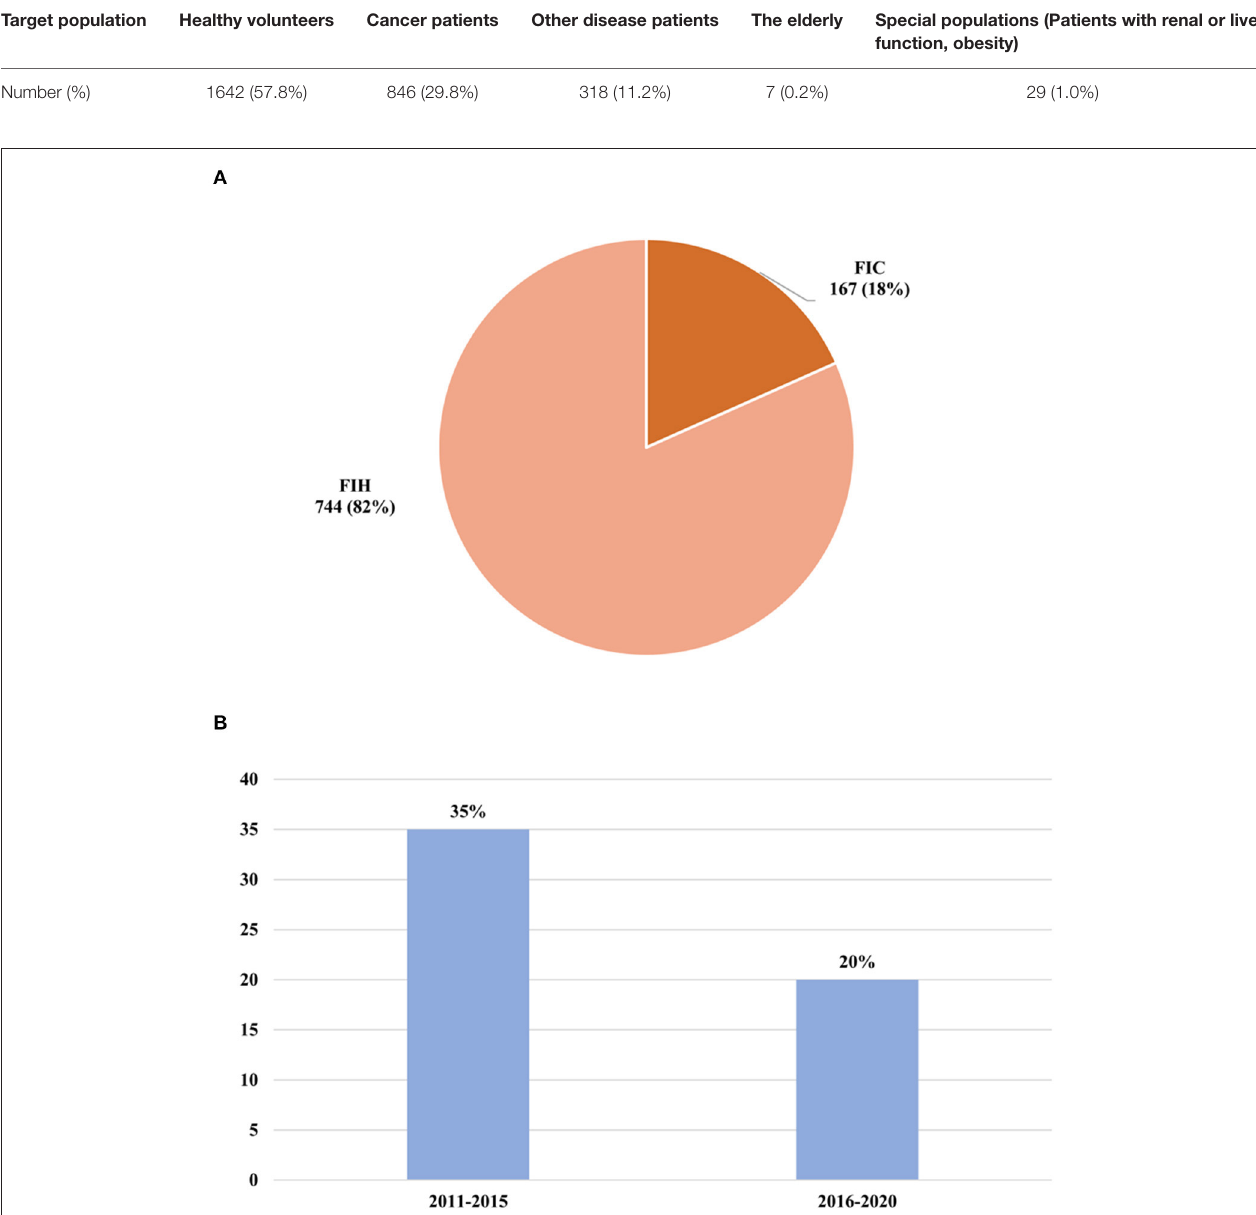
FIGURE 5 | Changes of newly tested innovative drugs. (A) Percentage of FIH or FIC clinical trials of newly tested innovative drugs conducted in mainland China during 2011–2020. (B) Successful rate of phase transition of a newly tested innovative drug. FIH, first in human; FIC, first in